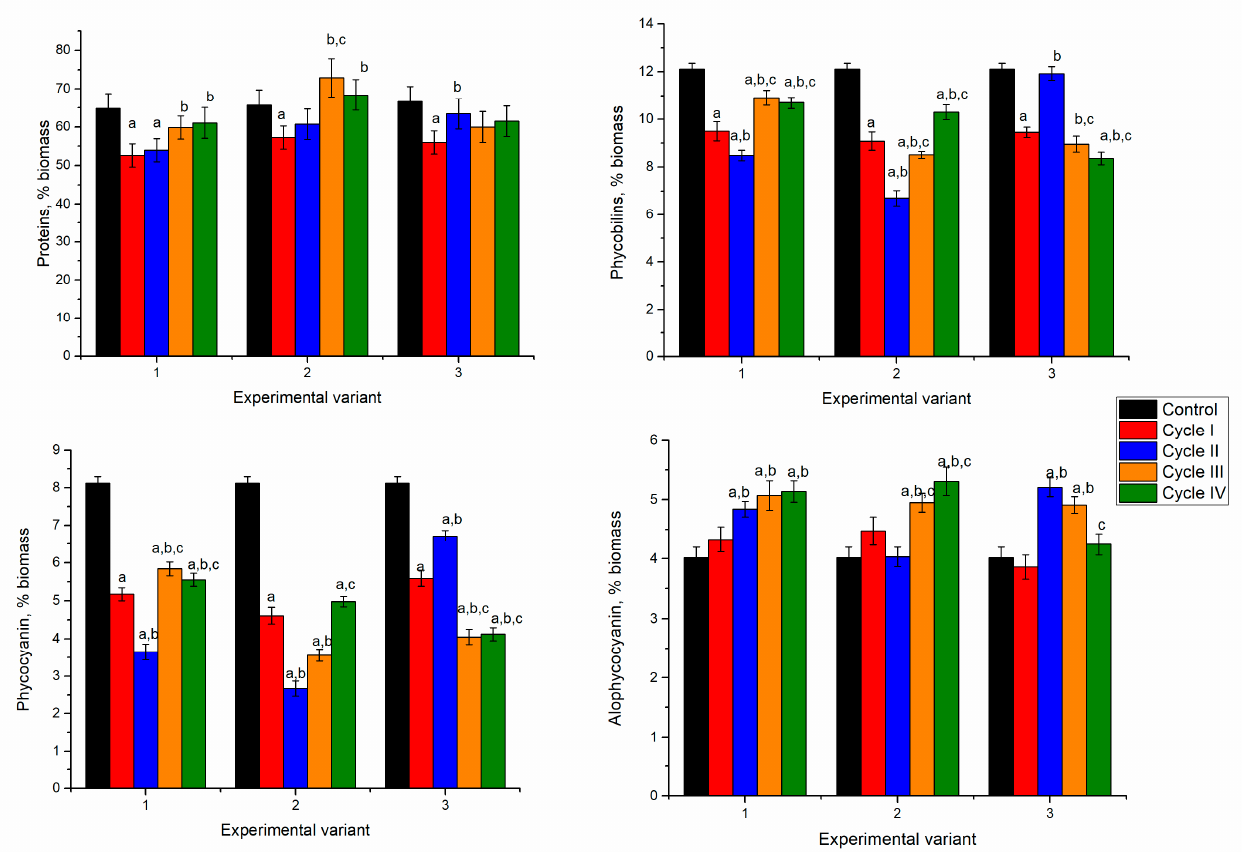
Figure 9. The content of proteins and phycobilins in spirulina biomass during repeated cultivation in the medium containing metal ions at concentrations: nickel 2.5–10 mg/L, copper 0.5–1 mg/L, strontium—1–5 mg/L, and Zn—0.5–2 mg/L. a: p < 0.001 for the difference between experimental and control samples; b: p < 0.001 for the difference from the first cycle; c: p < 0.001 for the difference from the second